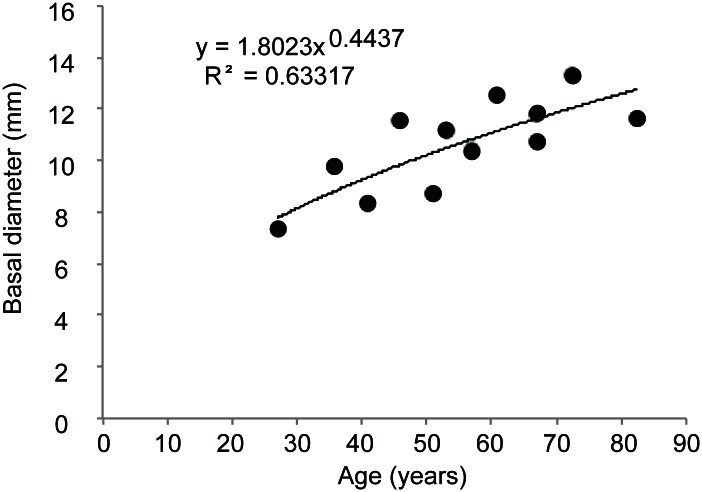
Relationship between estimated age and basal diameter of Atlantic populations of Corallium rubrum (n = 12).